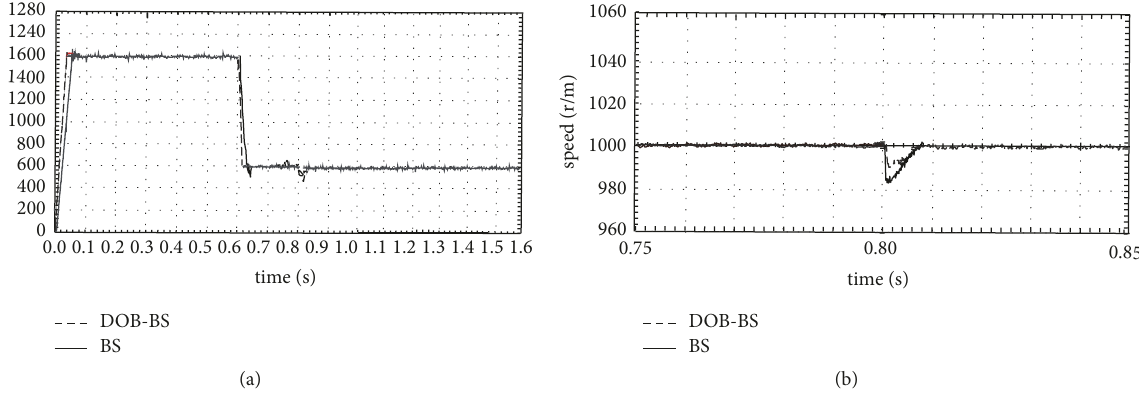
Figure 6: Rotation speed responses.